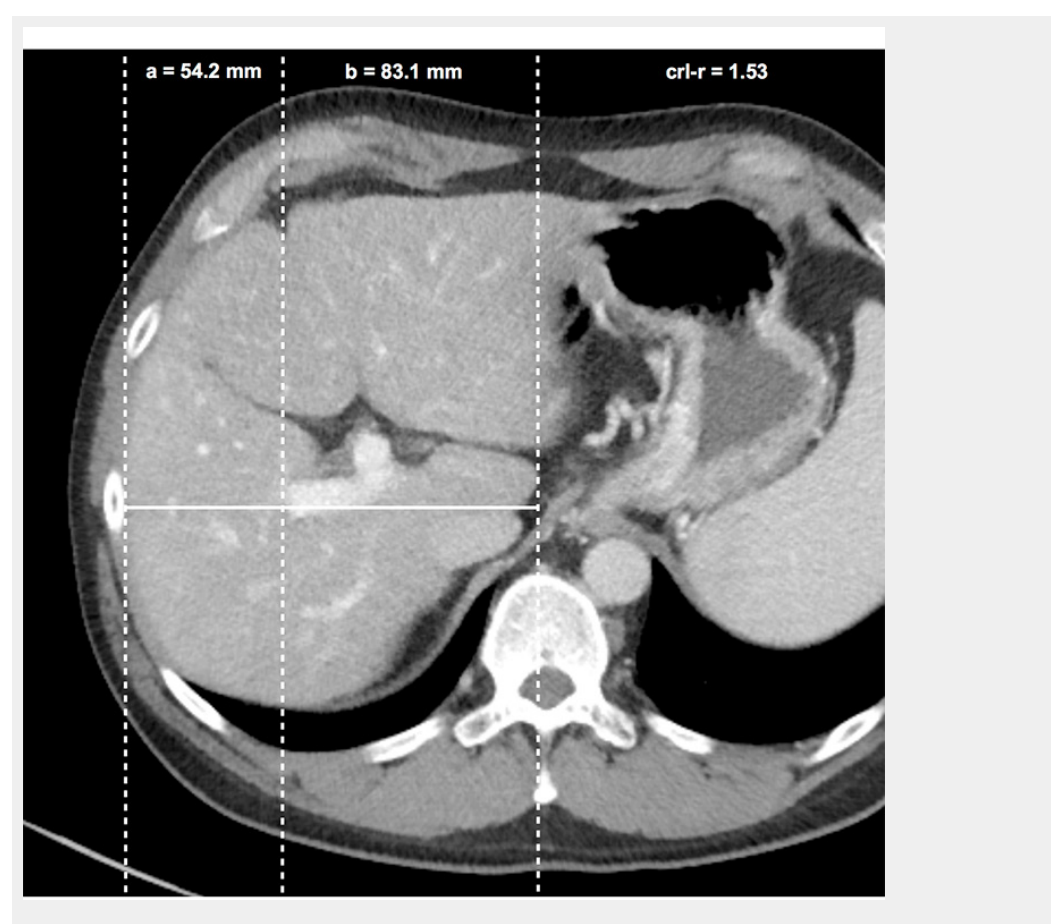
Figure 3 Caudate right-lobe ratio (crl-r) in a patient with liver fibrosis. In axial planes distances of the right lateral border of the right portal vein bifurcation to the lateral margin of the right hepatic lobe (a) and to the most medial margin of the caudate lobe (b) are measured in an exactly horizontal direction. The two distances were divided b / a (caudate lobe / right lobe) and defined as the caudate-right-lobe ratio